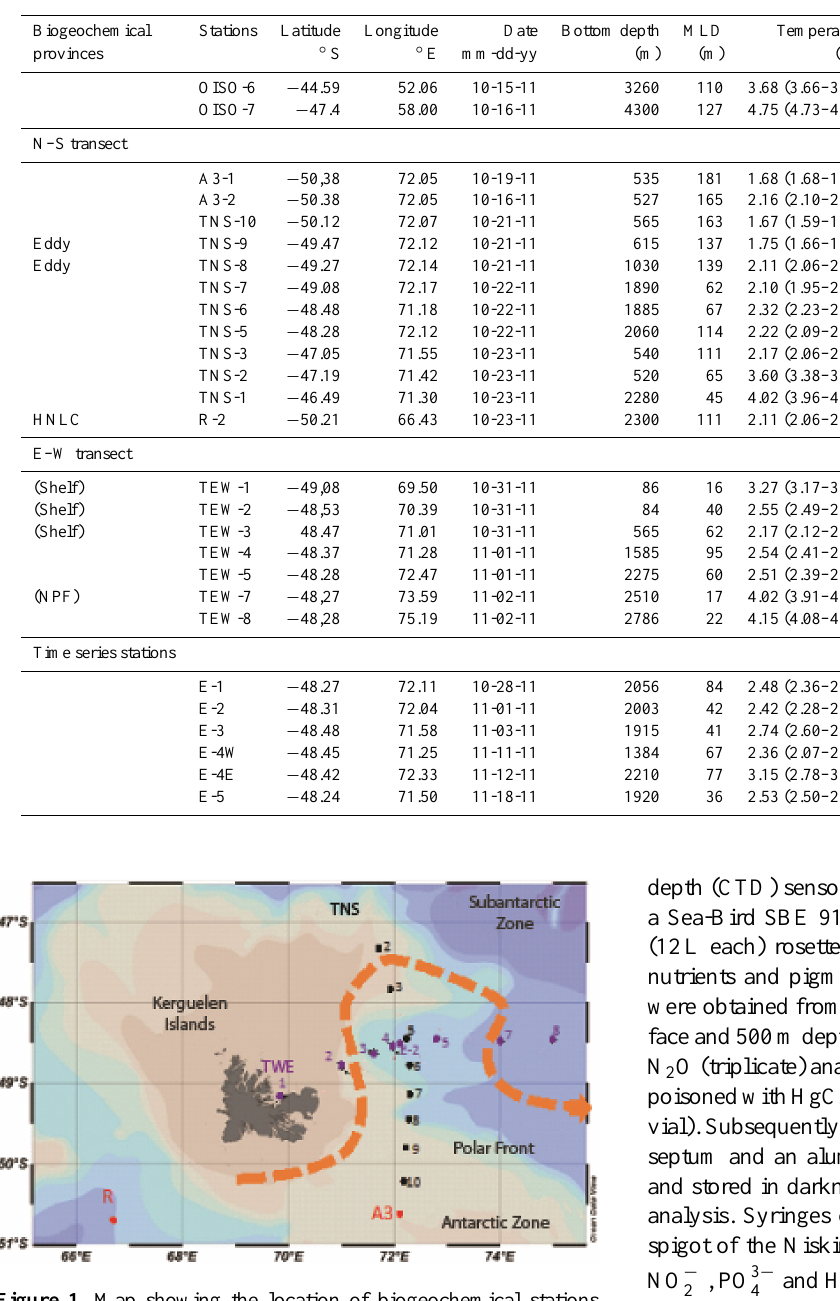
Figure 1. Map showing the location of biogeochemical stations sampled during the KEOPS 2 cruise. Bathymetric topography is shown in the main oceanographic region. The orange line delimits the position of the polar front. The transects are